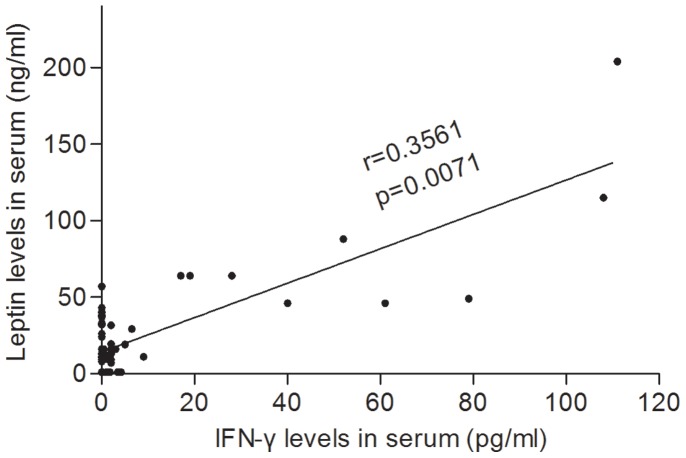
Leptin levels correlated with IFN-γ levels, r = 0.356, P<0.01 (Spearman’s r for non parametric values).There was no correlation between leptin and the other cytokines tested. Correlation is significant at the P<0.01 level (2-tailed).